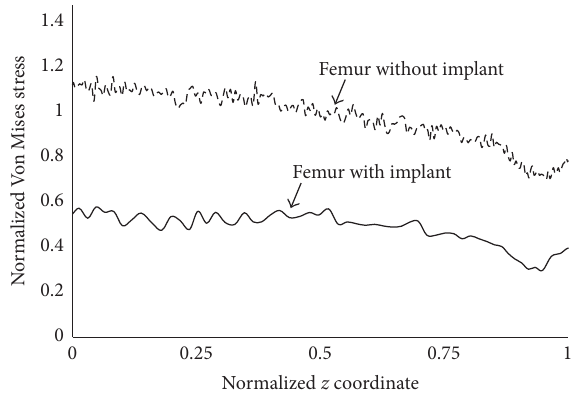
Figure 6: Stress distribution (moving average) over the surface of the cortical bone.